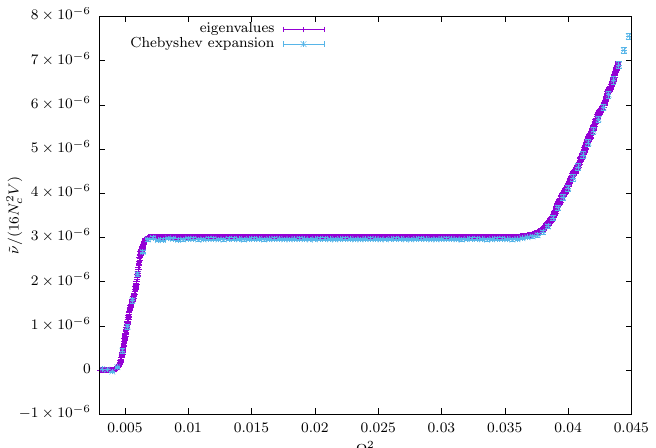
Figure 5. Normalized mode number obtained by two different methods on a V = 12 4 lattice for gauge group U(2) at λ lat = 1 , averaging over all 240 measured configurations. One method is the direct computation of the 2 × 6 lowest D † D eigenvalue pairs shown in figure 4. The other method is a stochastic estimation of the Chebyshev expansion with N p = 5000